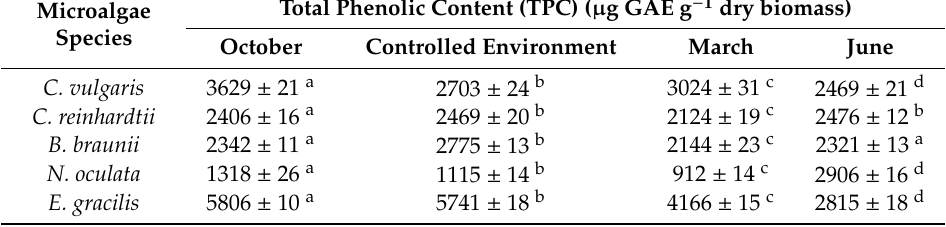
Table 3. Total phenolic content (TPC) (in µ g GAE- Gallic acid equivalent) g − 1 dry biomass) of the five microalgae species cultivated in the four di ff erent environmental